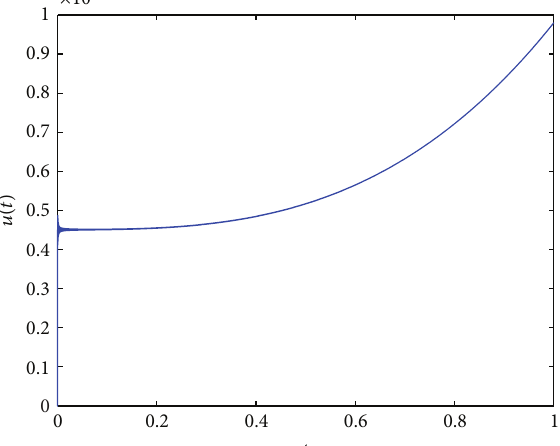
Figure 3: The displacement without a Wiener process, the numeri- cal simulation of (63), where 𝛼 = 1.625 , 𝛽 = 0.723